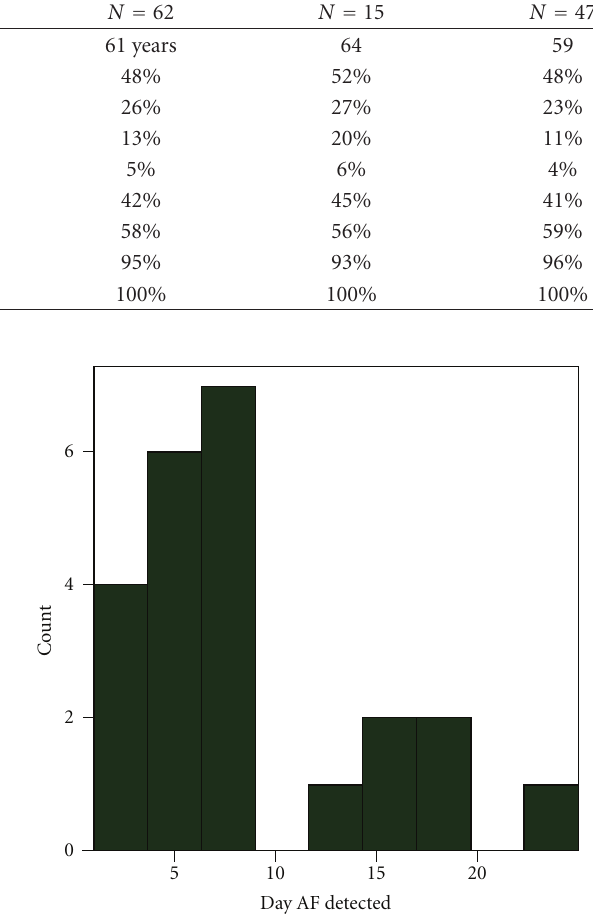
Figure 1: Day PAF detected on prolonged non-invasive cardiac